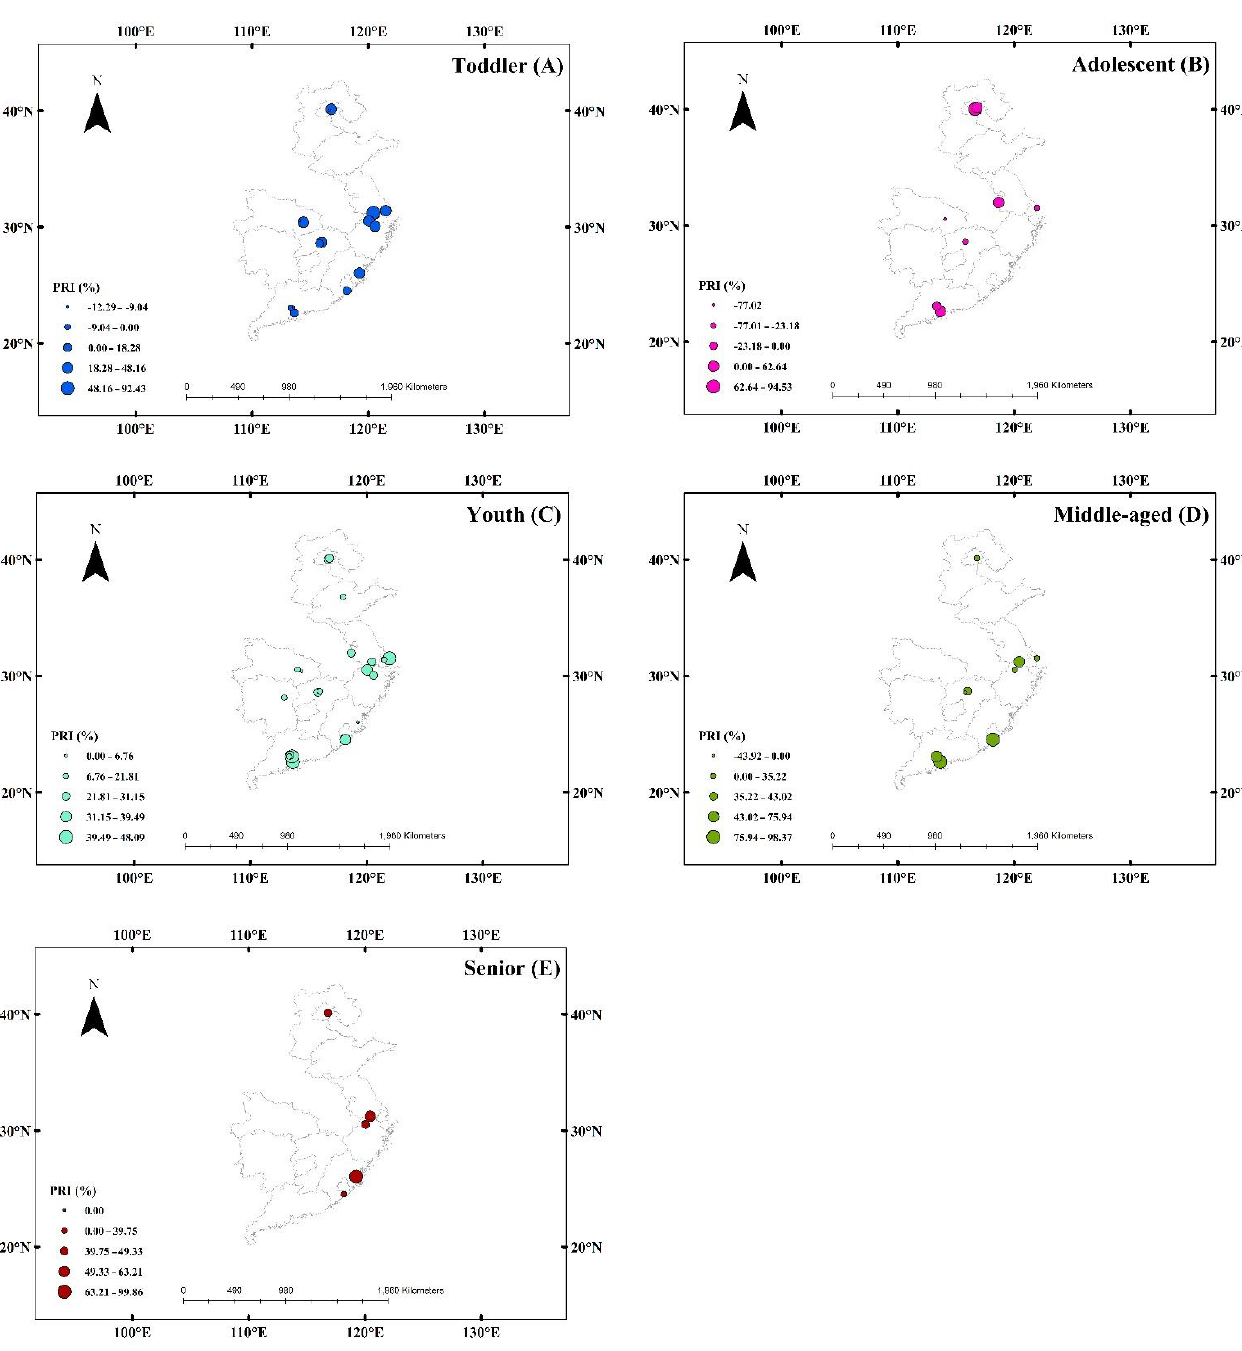
Figure 3. Spatial distribution patterns of positive response index (PRI) scores of wetland forest visitors at different ages. Circles present the level of happiness in a positive relationship. Table 3. Differences of happy and positive response index (PRI) scores for visitors in varied age ranges among wetland parks at different locations.